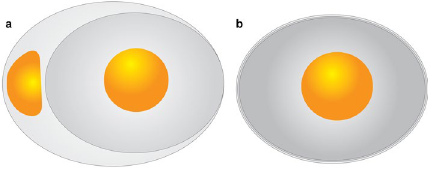
Figure 1. Pathologic cledoic eggs showing unusual morphology not similar to the normal eggs. ( a ) Ovum- in-ovo pathologic egg characterized by an egg within an egg or two yolks. ( b ) Multi-shelled egg distinctive of two or more than two eggshell layers surrounding an individual egg (modified after Carpenter 3 , software used Adobe Illustrator